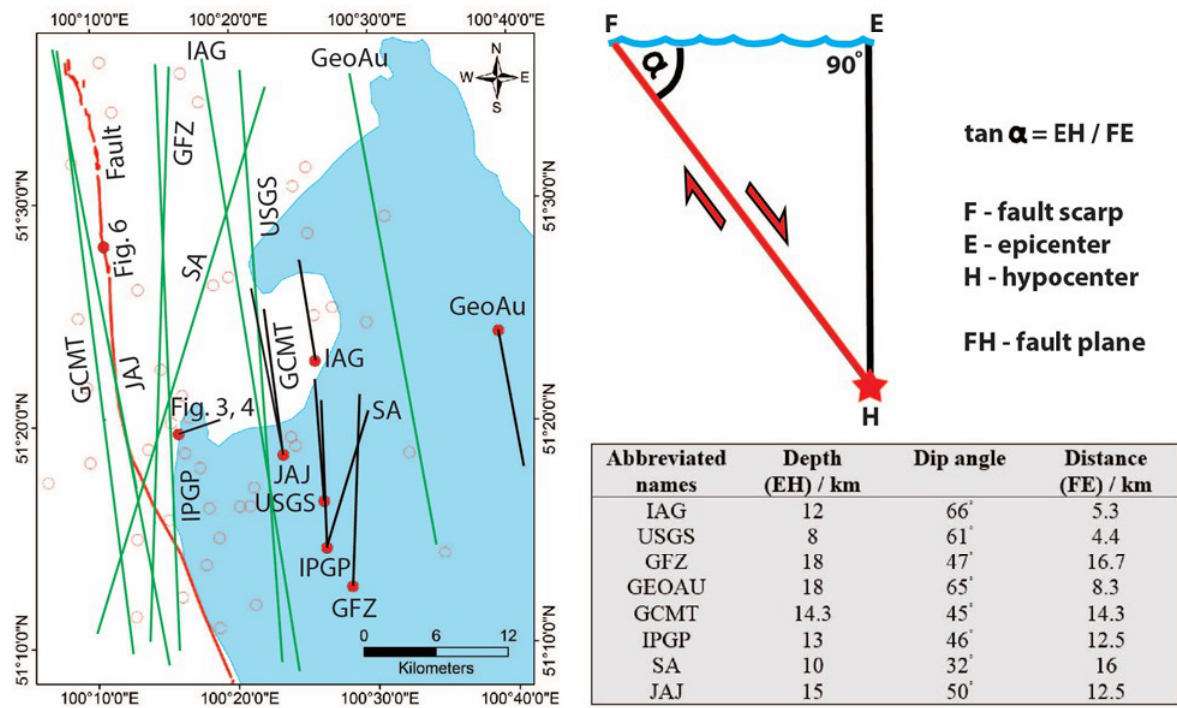
Fig. 7. Model of the projected fault scarps. The black lines show the strikes that were calculated by the seismological centers. The green lines are the projected (visualized) fault scarps based on information of the focal mechanisms (Fig. 2 and Fig. A2). The red circles except two circles (Figs. 3, 4 and 6) are the epicenters of the focal mechanisms. Figs. 3, 4 and 6 are the considerable surface rupture (See Fig. 2) during the co-seismic process. The hollow red circles represent aftershocks between M 4.1 and M 5.4 from the open-source data of USGS. w w The table demonstrate the distances between the projected fault scarps and the